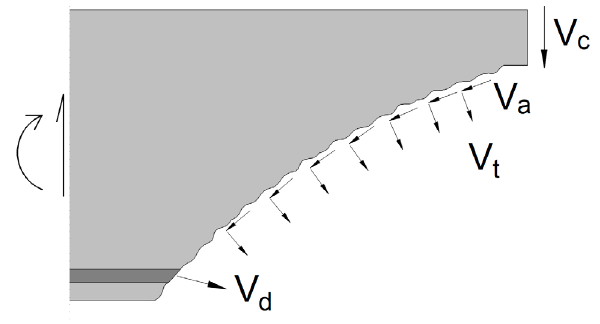
Figure 1. Shear transfer mechanisms in concrete members without transversal reinforcement: aggregate-interlock (V a ), dowel action (V d ), arc effect (V c ) and residual tensile strength in cracked concrete (V t